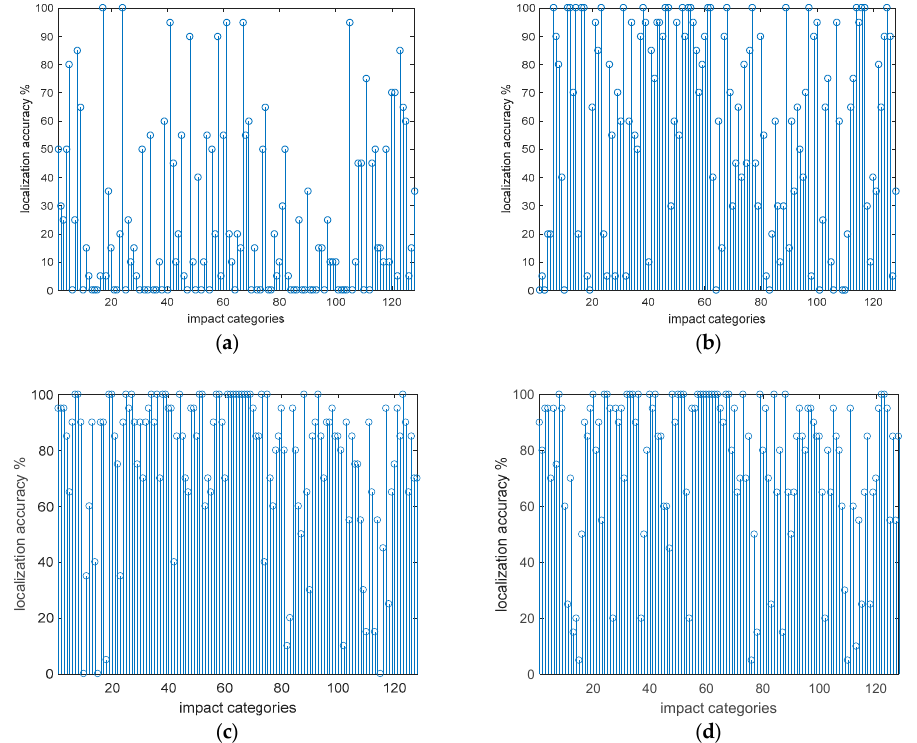
Figure 9. ( a ) The positioning accuracy when installing two sensors; ( b ) the positioning accuracy when installing there sensors; ( c ) the positioning accuracy when installing four sensors; ( d ) the positioning accuracy when installing four sensors, which are second non-inferior layer (10, 15, 35,